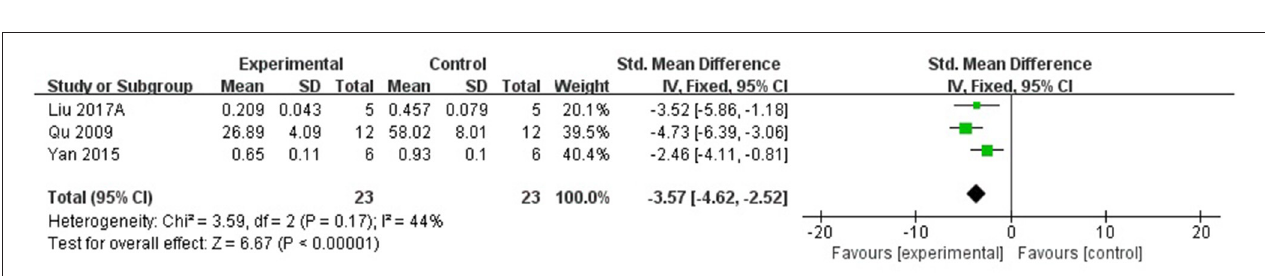
FIGURE 8 | (A) The forest plot: effects of textitRhodiola rosea L. for increasing acetylcholine; (B) The forest plot:effects of Rhodiola rosea L. for decreasing acetylcholinesterase compared with control group.